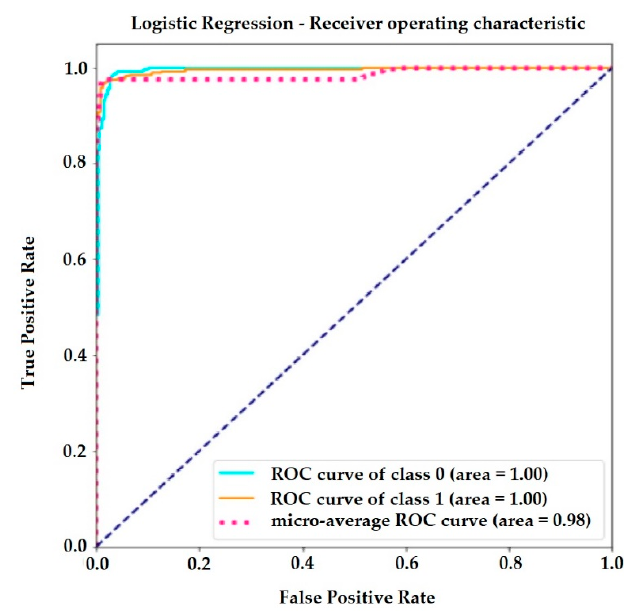
Figure 5. Receiver operating curve (ROC) curve of logistic regression.